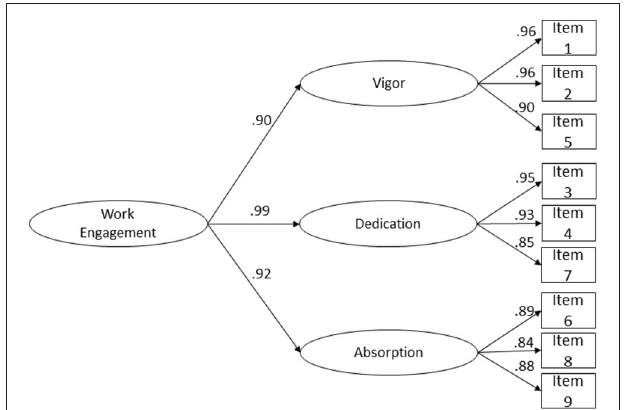
FIGURE 2 | UWES-9 second-order latent factor structure fit a combined sample of Portuguese ( n = 522) and Brazilian Workers ( n = 524). Second-order latent loadings for each factor, and factor loadings for each item are shown χ 2 (25) = 409.919, p < 0.001, N = 1,046, CFI = 0.998, NFI = 0.998, TLI = 0.997, RMSEA = 0.121, P(RMSEA ≤ 0.05) < 0.001, 90% CI (0.111; 0.132).